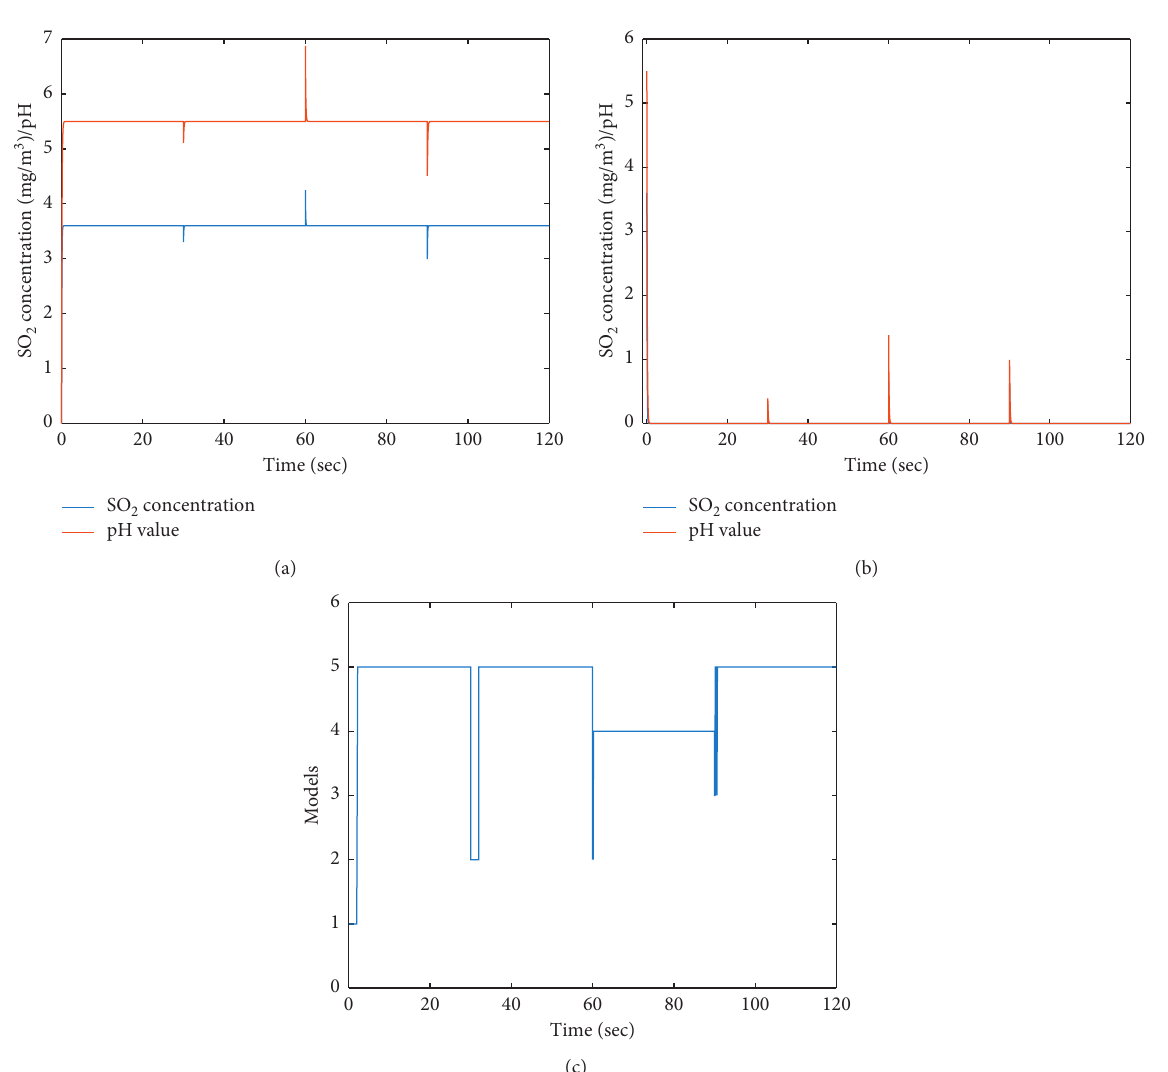
Figure 13: Control response of Case 4: (a) system outputs; (b) absolute value of the control error; (c) switching